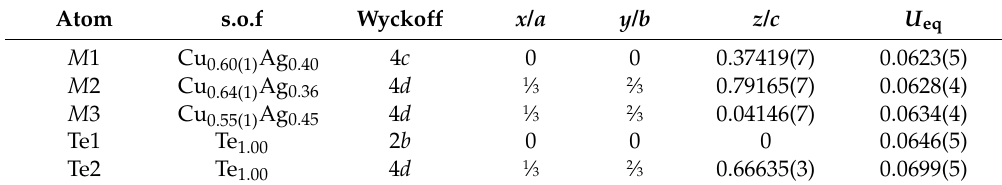
Table 5. Atoms, site-occupancy factors (s.o.f.), Wyckoff positions, atom coordinates and isotropic displacement parameters (Å 2 ) for spiridonovite.